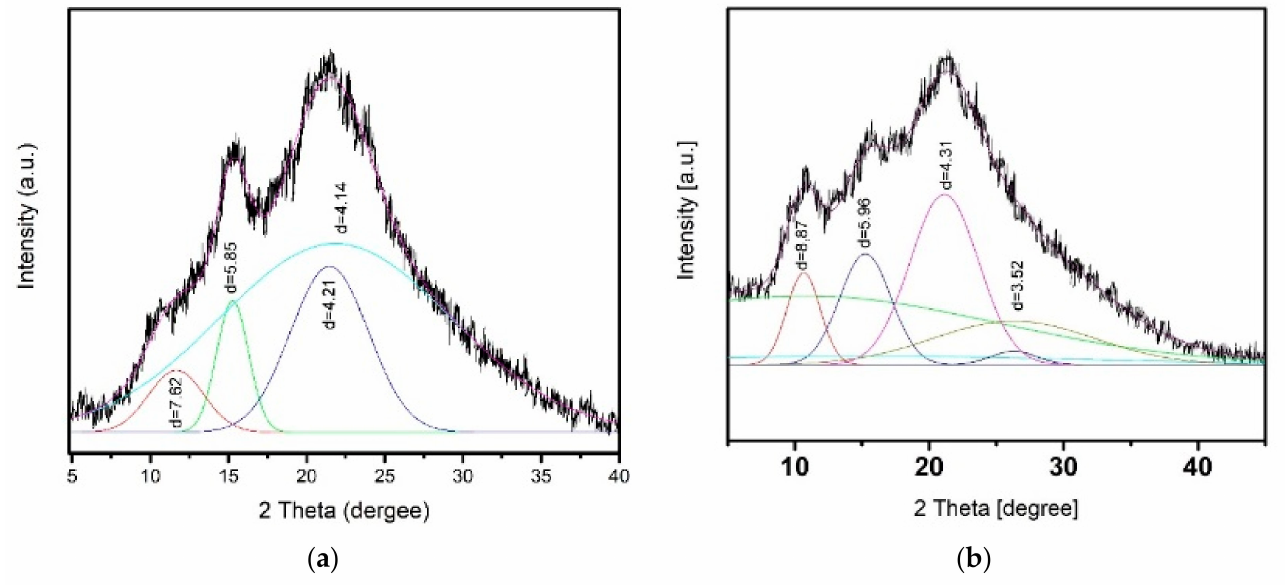
Figure 5. X-ray diffractograms of two-layer films (after removal of the water-soluble polyanion layer): ( a ) CS b –PEC SEC ; ( b ) CS b –PEC HA , obtained from the PEC